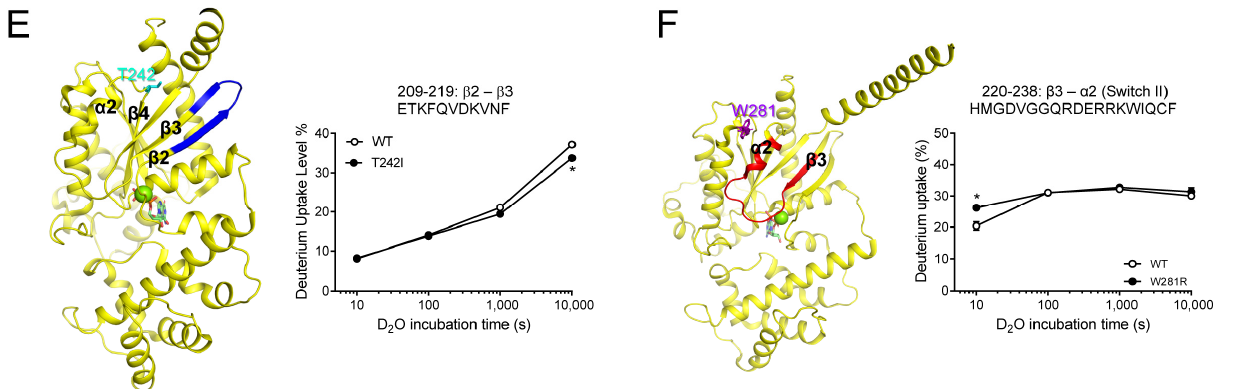
Figure 5. Effects of T242I, R280G, and W281R on the intrinsic GDP/GTP turnover rate and HDX-MS profiles. ( A ) Positions of T242I, R280G, and W281R are shown as sticks on the structure of GDP-bound G α s (PDB: 6EG8). ( B – D ) BODIPY-FL-GTP γ S fluorescence change of T242I (cyan) ( B ), R280G (green) ( C ), and W281R (purple) ( D ). BODIPY-FL-GTP γ S fluorescence was presented as percent (%) of WT G α s maximum. Data are presented as the mean ± SD of more than three independent measurements. ( E , F ) HDX-MS profiles of T242I ( E ) and W281R ( F ) are presented as color code on the structure of GDP-bound G α s (PDB: 6EG8), and uptake plots of selected peptides are shown. Red represents higher deuterium uptake of G α s natural variants compared to the WT. Blue represents lower deuterium uptake of G α s natural variants compared to the WT. The mutated residues are shown as sticks. * indicates statistical differences between the natural variant and WT ( p <